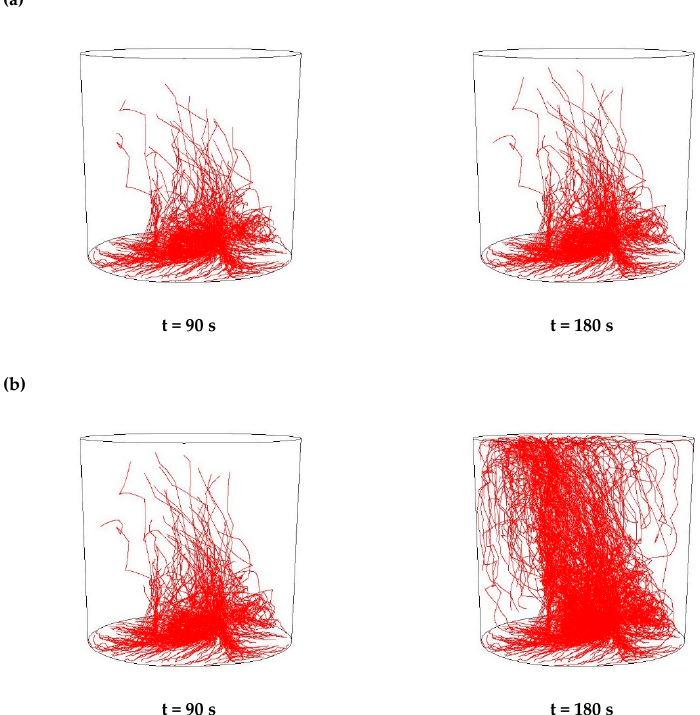
Figure 9. Trajectories of non-metallic Al 2 O 3 inclusions for the case of argon flow of 50 L/min for the particle diameters of ( a ) 18 µm and ( b ) 27 µm in the 18CrNiMo7-6 steel.